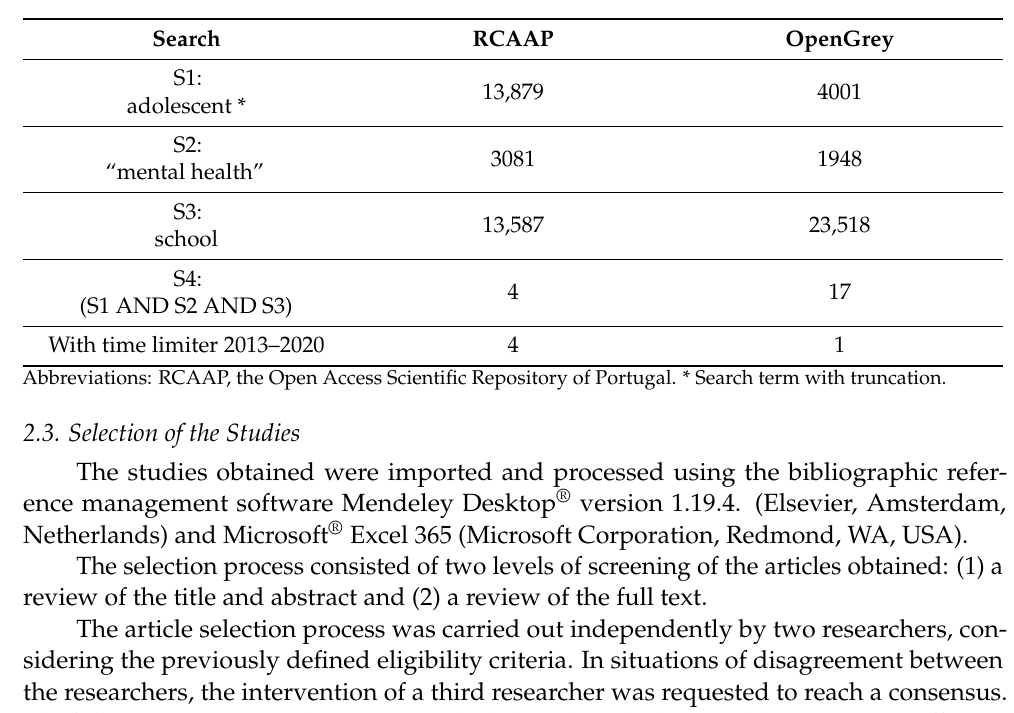
Table 2. Studies obtained by search term and